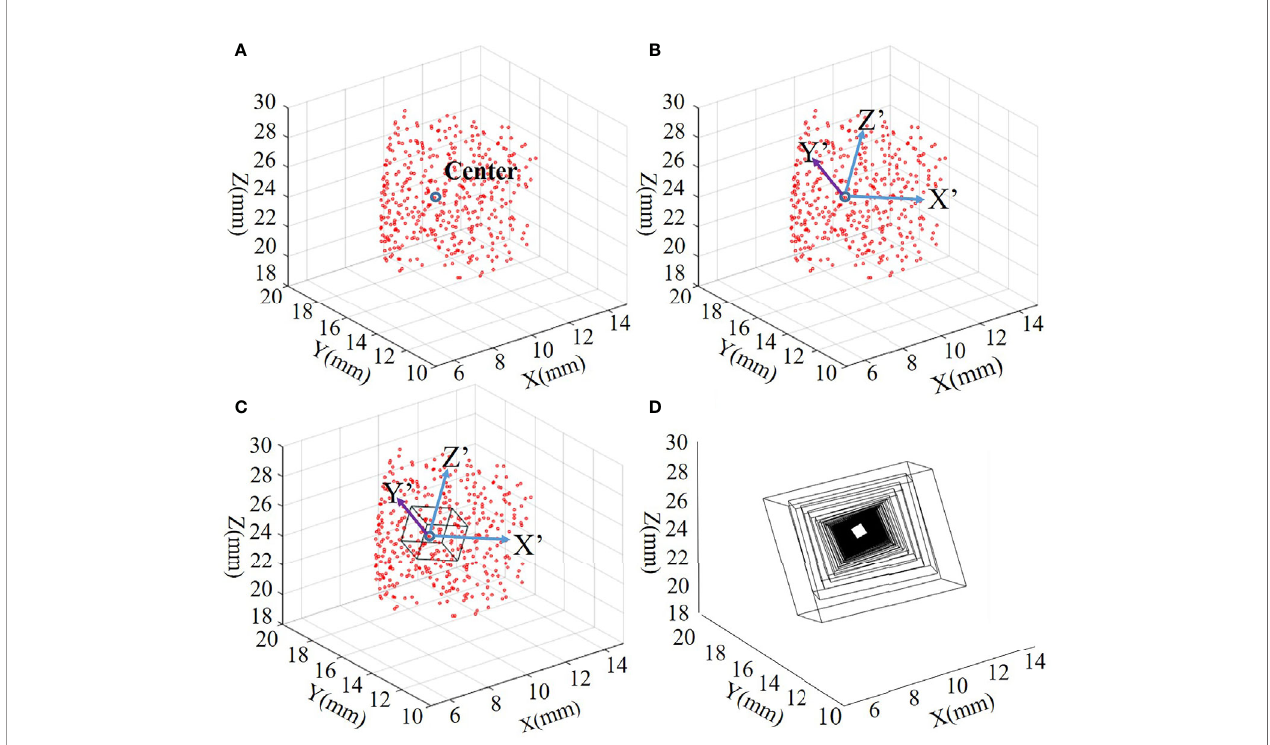
FIGURE 2 | (A – C) Examples of one of the ROI division processes. (D) The ROI trajectory of the entire iterative process. ROI, region of